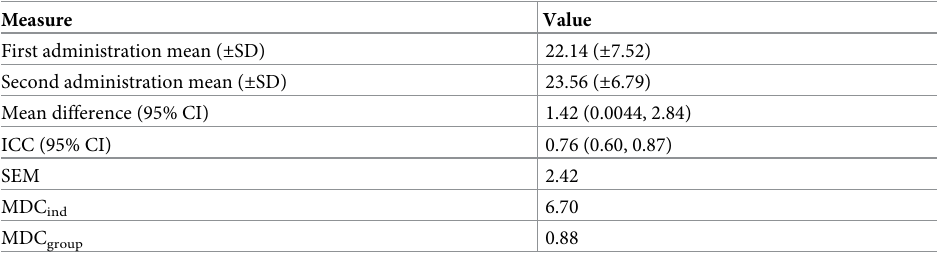
Table 4. Reliability measures of the DFSBS-D (n =